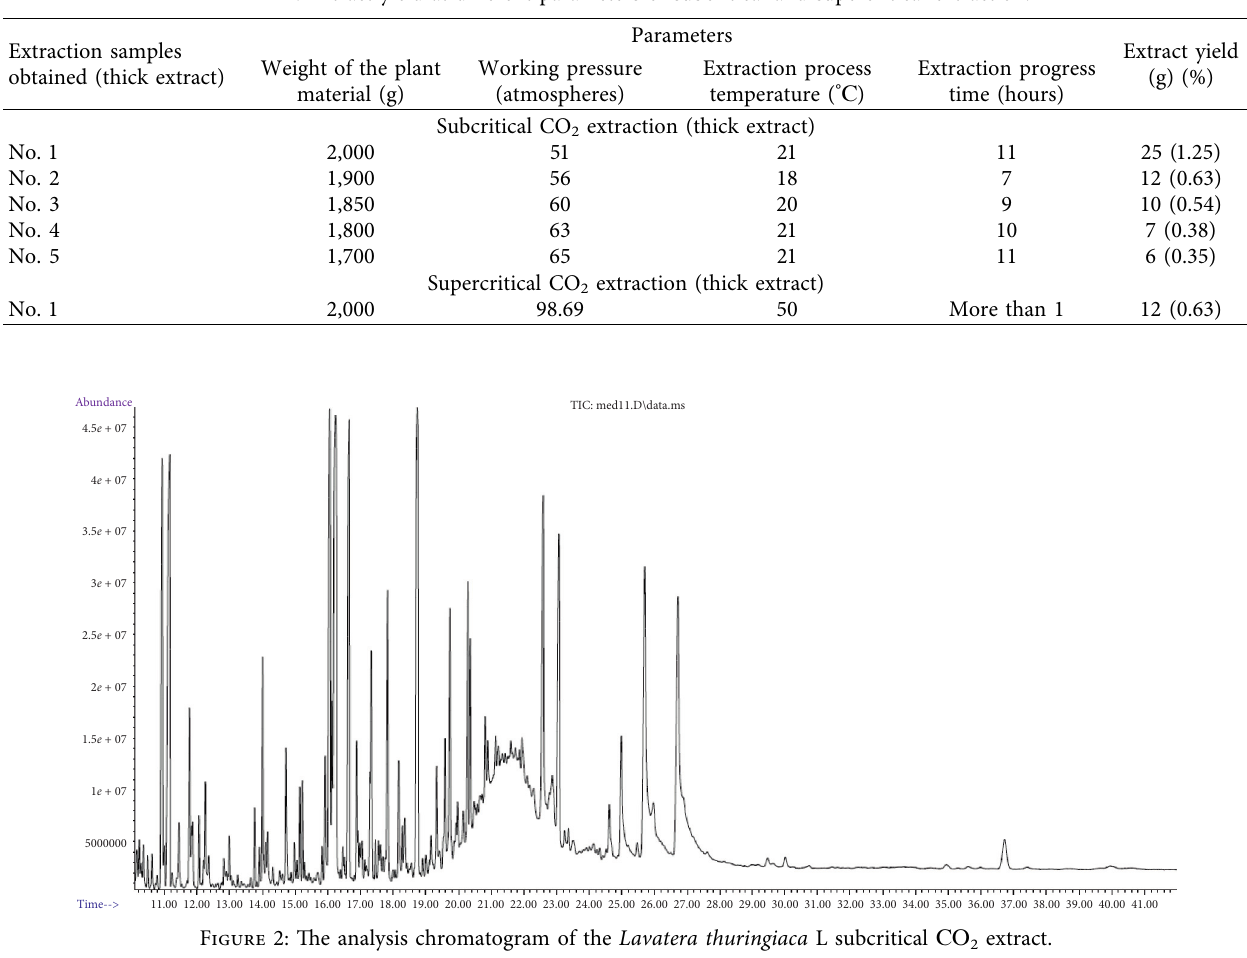
Table 2: Extract yield at different parameters of subcritical and supercritical extraction.